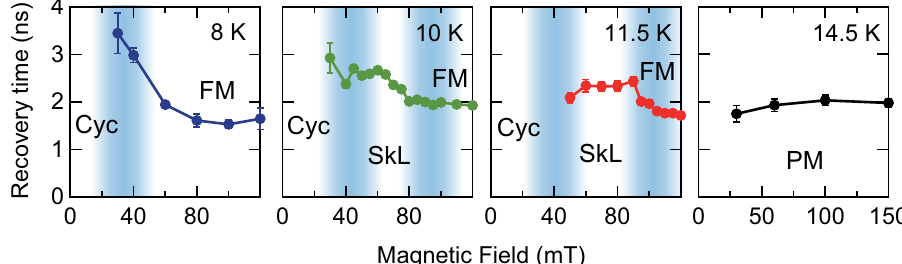
Fig. 3 Change of the remagnetization across the magnetic phase transition. Time constant of the remagnetization process at 8 K, 10 K, 11.5 K, and 14.5 K are plotted. The blue-shaded areas are guides to the eye indicating the magnetic phase transition. Error bars are the standard deviation of the fi tting